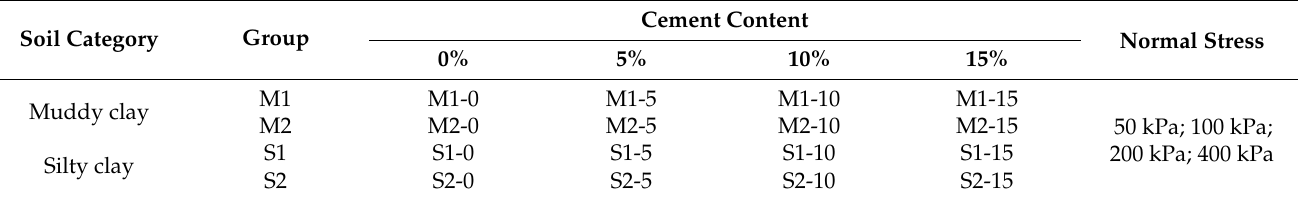
Table 4. Samples of different soils and cement